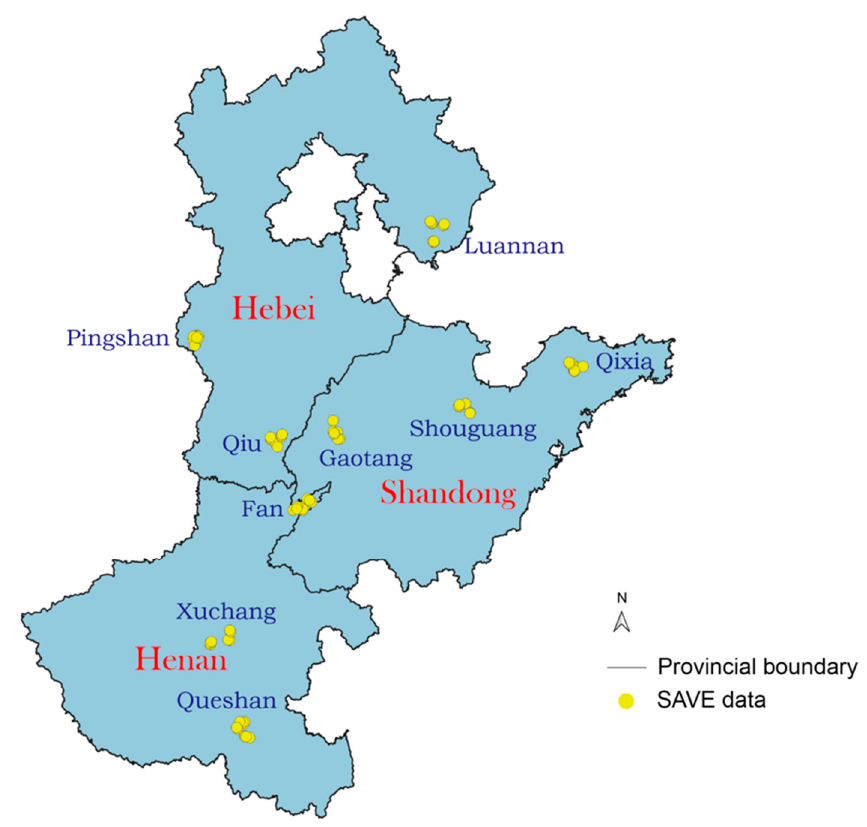
Figure 3. The geographical location of the samples. Before estimation, the data were processed as follows. (1) The variables related to price were processed using the national Consumer Price Index (CPI, 2012 = 100) to eliminate the effect of inflation. (2) Only farms with a wheat-sown area greater than 0 and less than 2 ha (the threshold of smallholder farm) were kept. (3) To reflect the opportunity cost of land transfer, missing values for land tenure were replaced with the provincial median in the same year. (4) To exclude the effect of machinery subsidy, the households that